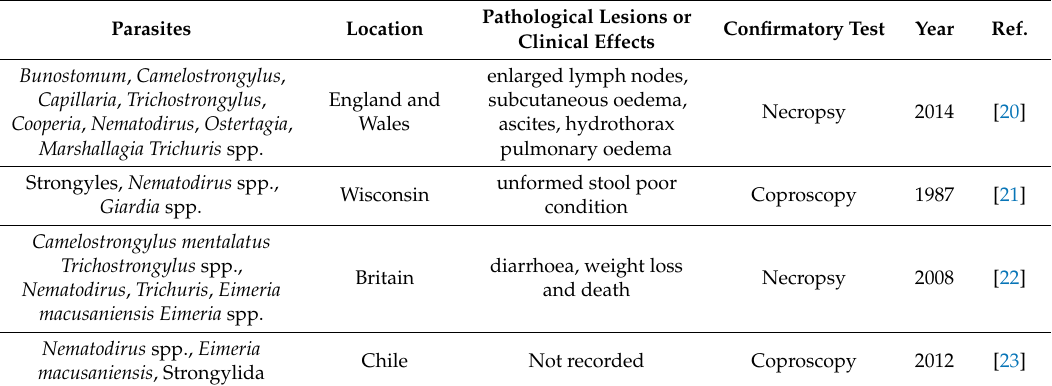
Table 1. Gastrointestinal Parasites present in South American Camelids and its effect on the animals. Pathological Lesions or Parasites Location Confirmatory Test Year Clinical Effects